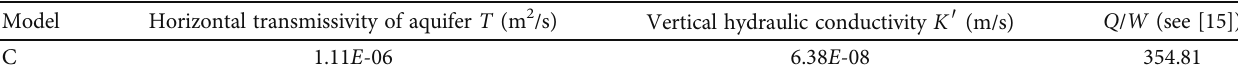
Table 4: Derived key parameters from model C of the barometric